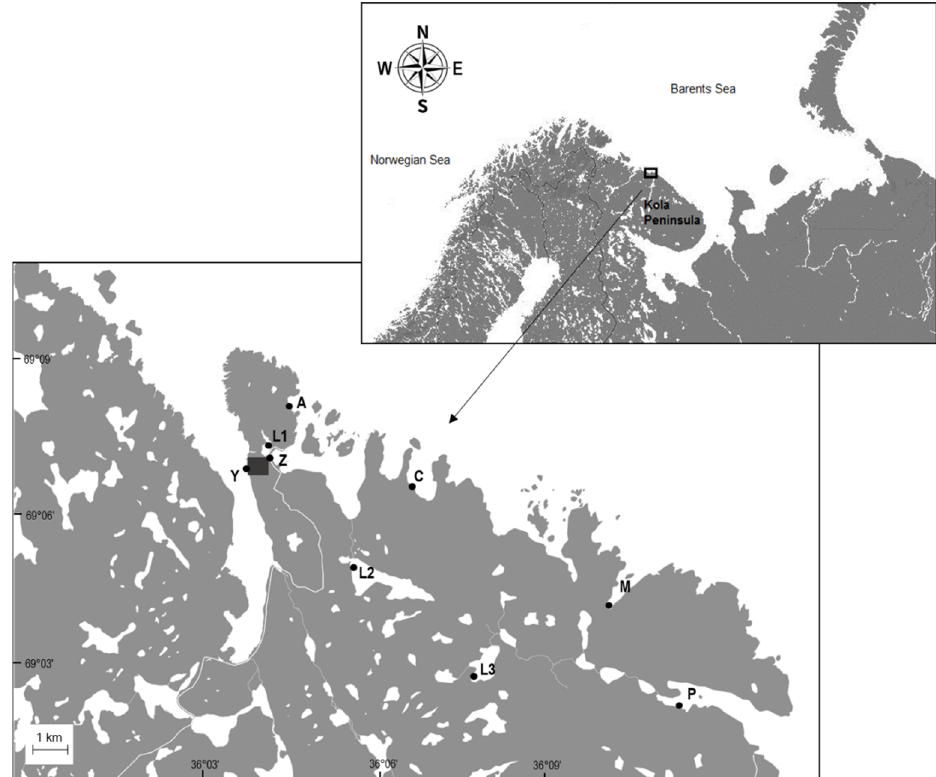
Figure 1. Map of the sampling sites in the Kola Peninsula. Water samples were collected from six bays of the Barents Sea—(A) Avarijnaya, (C) Plokhie Chevry, (M) Medvezhya, (P) Porchnikha, (Y) Yarnyshnaya, and (Z) Zelenetskaya—and three freshwater lakes located in the tundra region—L1, L2, and L3. The field station is marked by a grey square.